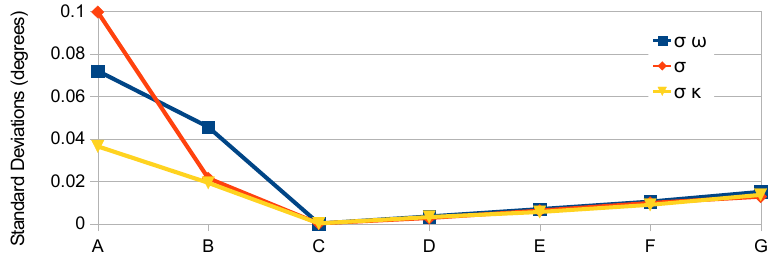
Figure 7. Standard deviations of rotation elements of the Relative Rotation matrix computed from estimated exterior orientation parameters (EOP).